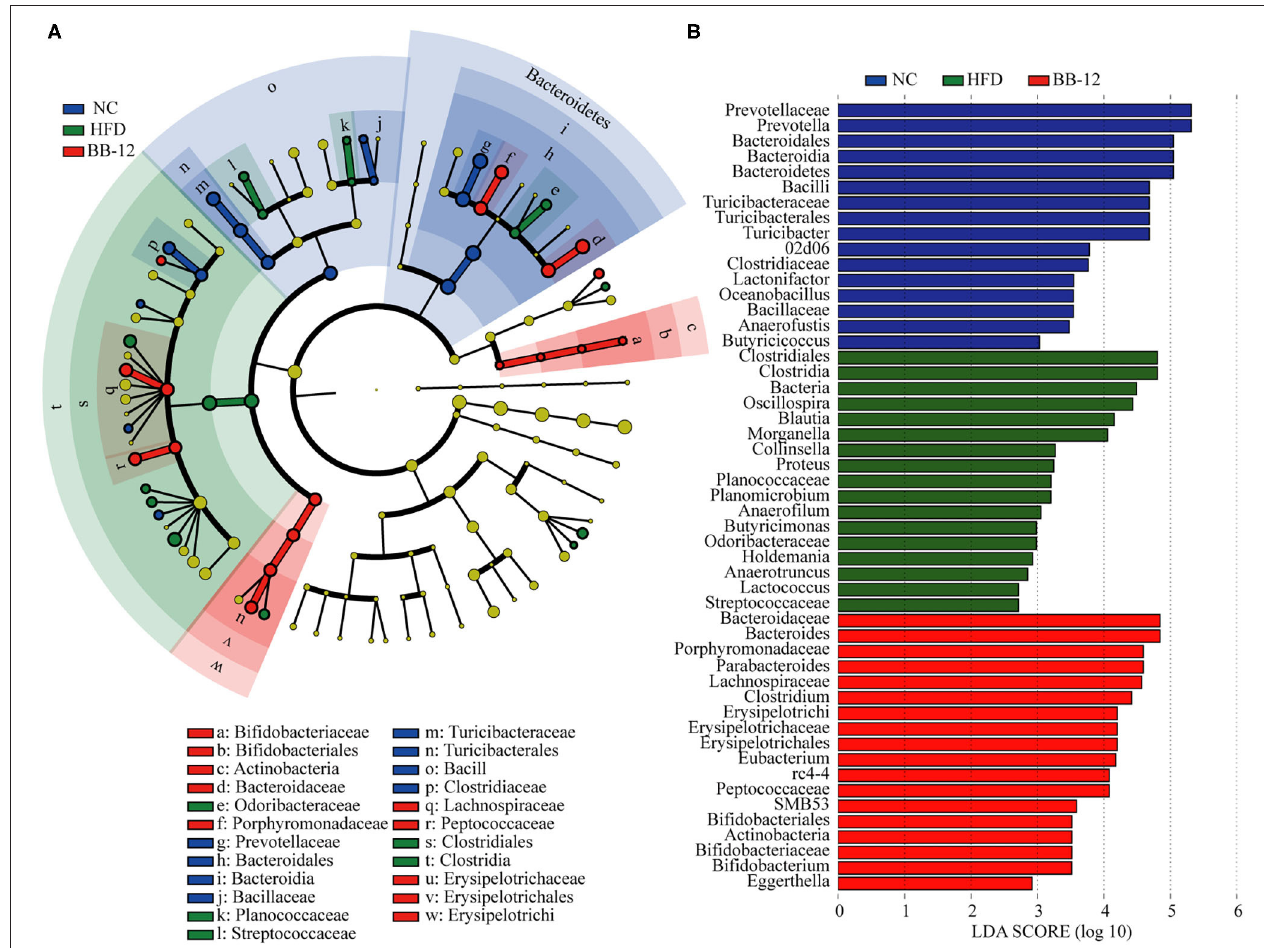
FIGURE 5 | Linear discriminant analysis (LDA) effect size (LEfSe) analysis of bacterial community composition based on relative abundances of 16S rRNA from 16 colonic contents samples. (A) LEfSe cladogram representing different abundant taxa; and (B) LDA scores as calculated by LEfSe analysis. Only taxa with LDA scores of more than 2 were